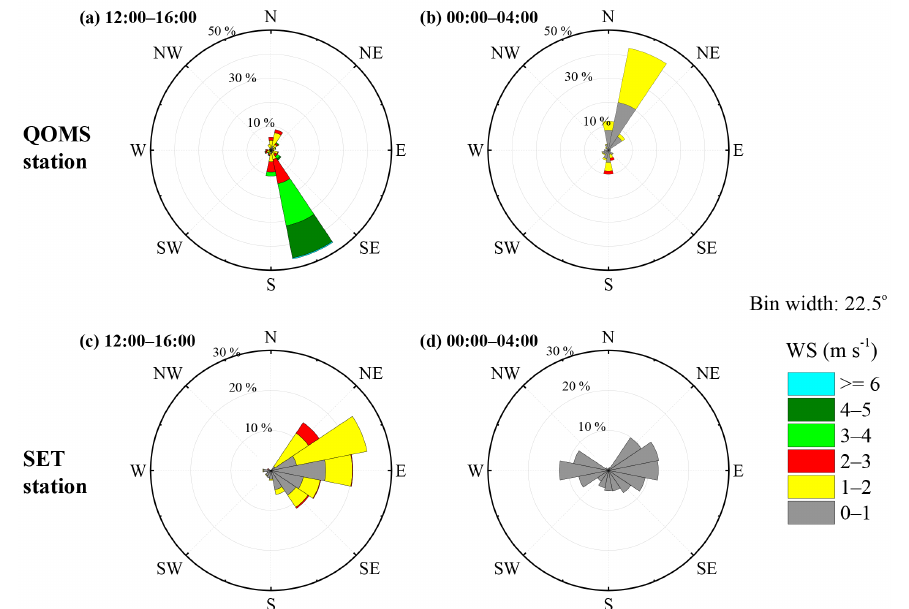
Figure 6. Wind rose plots for afternoon (12:00–16:00LT) and nighttime (00:00–04:00LT) in July and August at the QOMS station (a, b) and the SET station (c, d) . An hourly horizontal wind direction (WD) was used, with its radii values expressed as percentages for wind blowing from particular